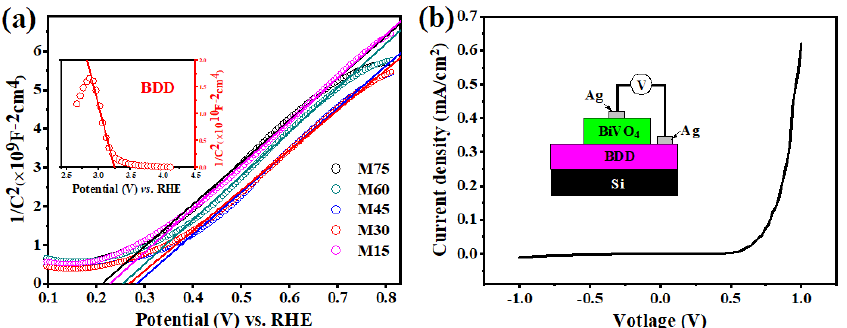
Figure 4. ( a ) The Mott-Schottky plots for the BiVO 4 /BDD heterojunction photoanodes and (inset) the BDD; ( b ) The current-voltage curve of the BiVO 4 /BDD heterojunction photoanode and (inset) the schematic diagram of the corresponding illustration.